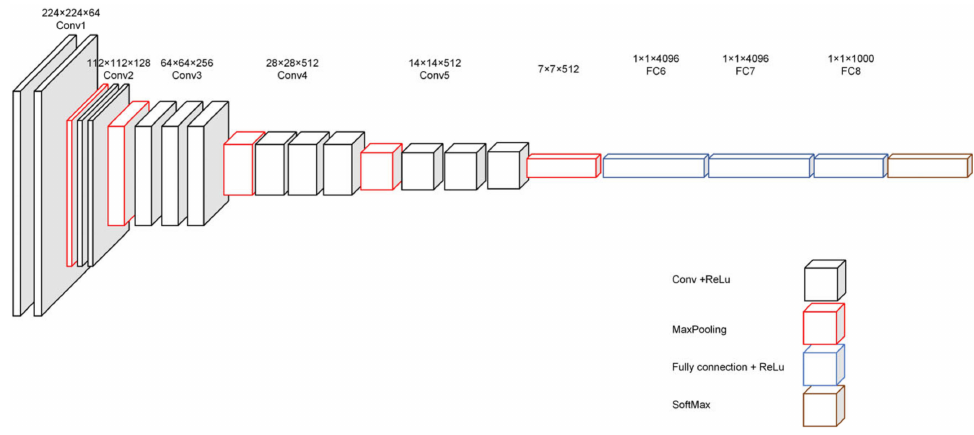
Figure 1. VGG—16 network architecture diagram.